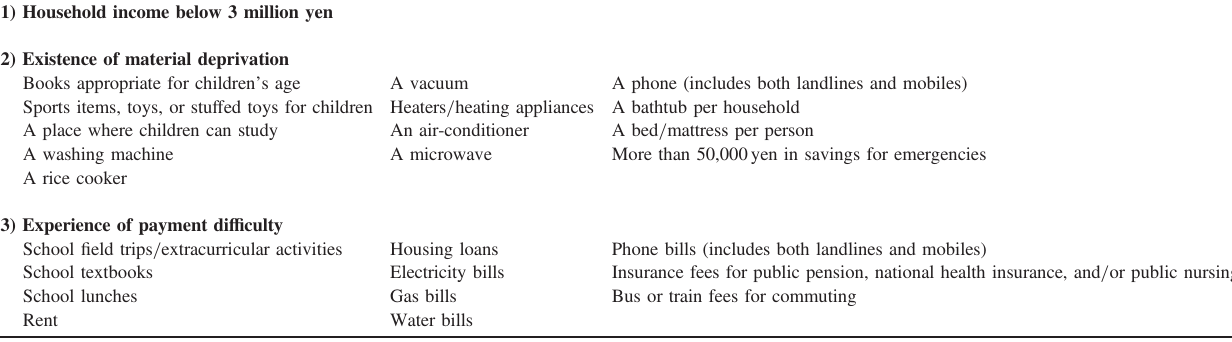
Table 4. De fi nition categories of “ Living di ffi culty ” in A-CHILD study